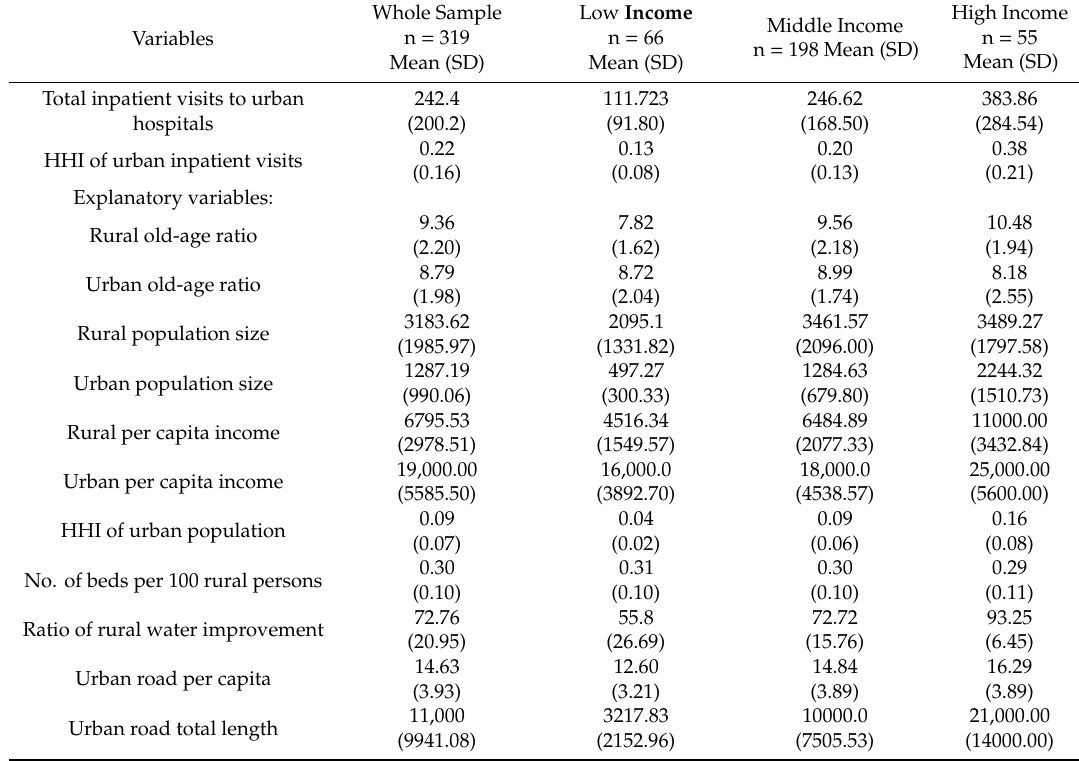
Table 1. Description of main